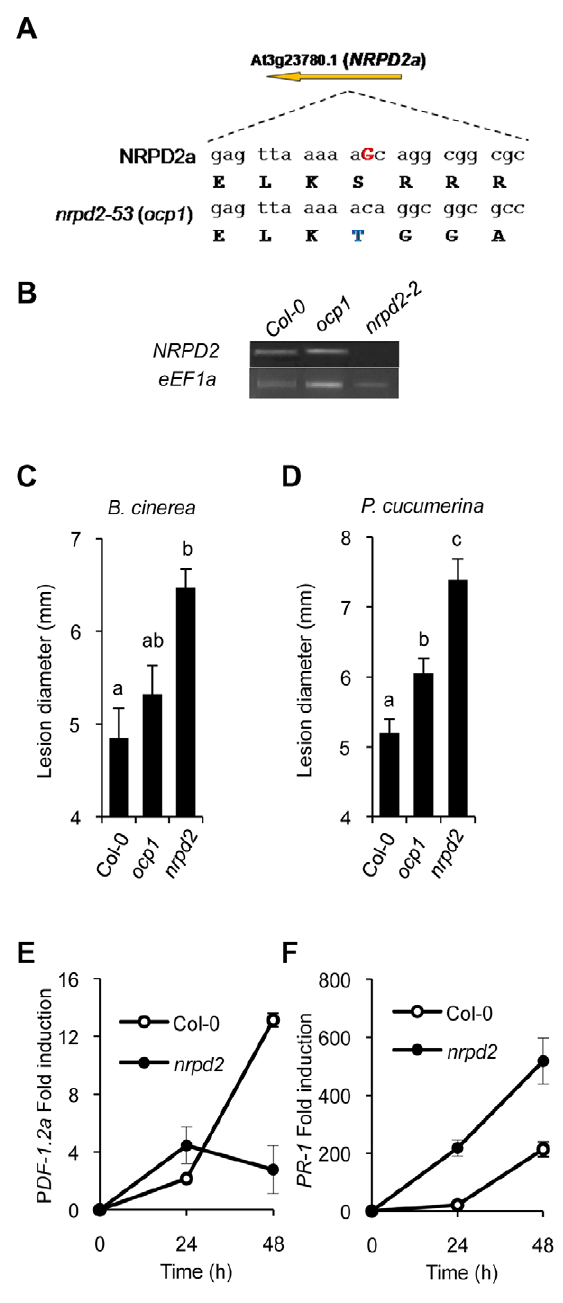
Figure 2. ocp1 is a mutant allele of NRPD2 . (A) OCP1 corresponds to At2g27040 encoding NRPD2. The G nucleotide residue deleted in the ocp1 allele is indicated in red bold uppercase letters in the wild-type sequence. Deduced amino acid sequences are indicated below each nucleotide triplet, and the first amino acid change (S to T) where the frameshift of the OCP1 protein starts is shown in blue. (B) NRPD2 expression level by RT-PCR in mRNAs derived from Col-0, nrpd2-2 and ocp1 plants. The eEF1a house-keeping gene was used as a control. (C– D) nrpd2 plants show enhanced susceptibility to fungal pathogens. Lesion size was measured in Col-0, ocp1 and nrpd2-2 plants after inoculation with B. cinerea (C) or P. cucumerina (D). Data points represent average lesion size 6 SE (n $ 30 lesions). ANOVA detected significant differences at the P , 0.05 level. (E–F) RT-qPCR determination of PDF1.2a (E) and PR-1 (F) transcript levels following inoculation with P. cucumerina . Data represent the mean 6 SD; n=3 biological replicates.